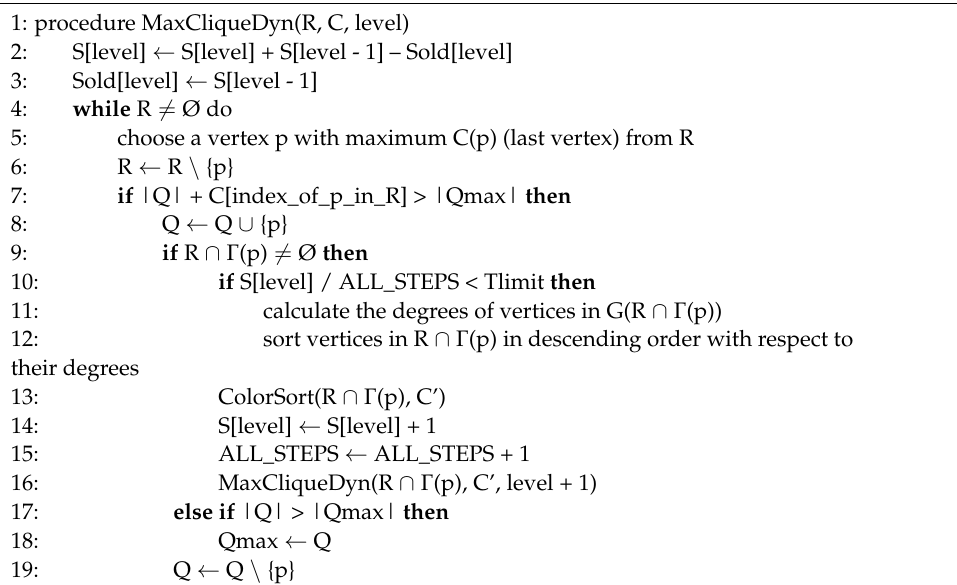
Algorithm 1. Dynamic algorithm for maximum clique